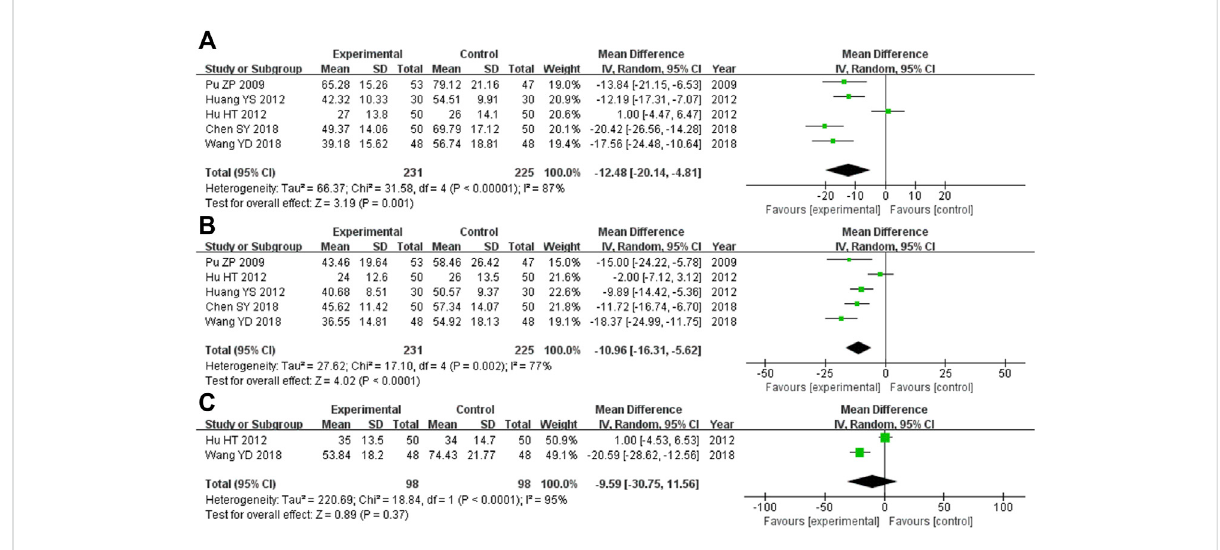
FIGURE 4 Comparative forest plot: liver function indices. (A) The pooled MD was − 12.48 (95% CI − 20.14 to − 4.81, p = 0.001). The ALT levels in the experimental cohort were signi fi cantly lower than those in the control cohort. (B) The pooled MD was − 10.96 (95% CI − 16.31 to − 5.62, p < 0.0001). The AST levels in the experimental cohort were signi fi cantly lower than those in the control cohort. (C) The pooled MD was − 9.59 (95% CI − 30.75 to 11.56, p = 0.37). There was no signi fi cant variation between the experimental and control cohorts for GGT. MD, mean difference; ALT, alanine aminotransferase; CI, con fi dence interval; AST, aspartate aminotransferase; GGT, γ -glutamyl